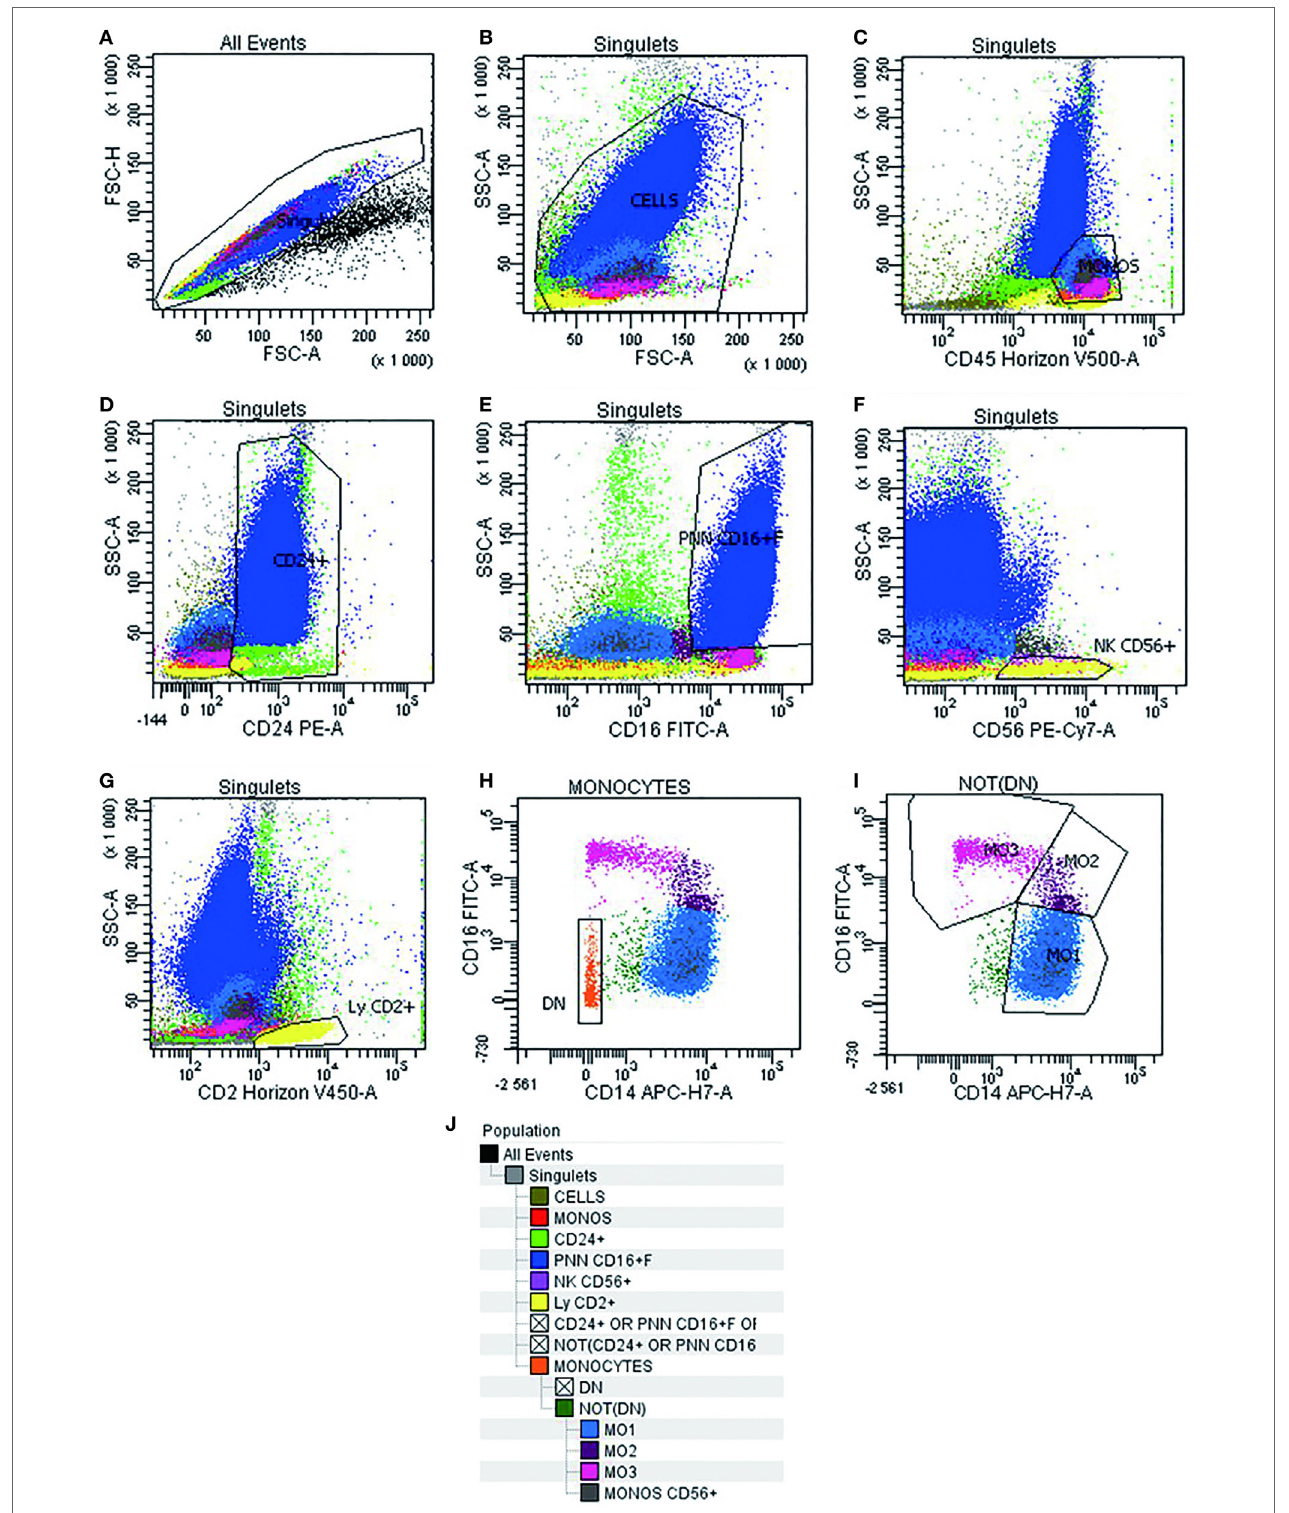
FigUre 1 | Gating strategy used in multiparametric flow cytometry analysis to detect different subsets of monocytes. Doublets exclusion on FSC-A/FSC-H dot plot (a) . Live cells on FSC-A/SSC-A (B) . Monocytes identification as CD45 + /SSC intermediate cells (c) . Invert gate and exclusion of cells expressing CD24 + , granulocytes expressing CD16 + high , and lymphocytes expressing CD56 + and CD2 + (D–g) . Exclusion of residual cells CD14 − CD16 − (h) . Characterization of human monocyte subsets into CD14 + /CD16 − (MO1, conventional), CD14 + /CD16 + (MO2, intermediate), and CD14 low /CD16 + (MO3, unconventional) subsets (i) . Cell hierarchy (J) .